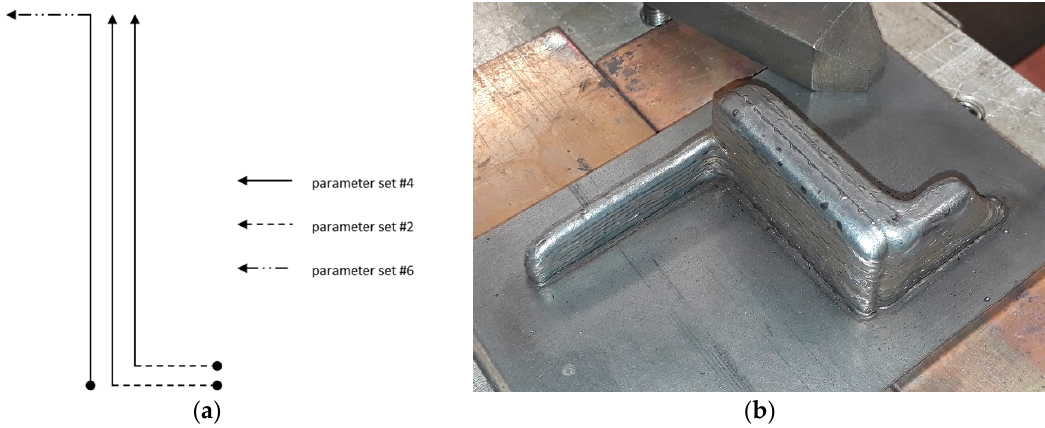
Figure 6. ( a ) Top view of the path strategy for the corner feature of the 15 mm, 8 mm and 4 mm walls of the AM-part; ( b ) implementation of the strategy in a preliminary